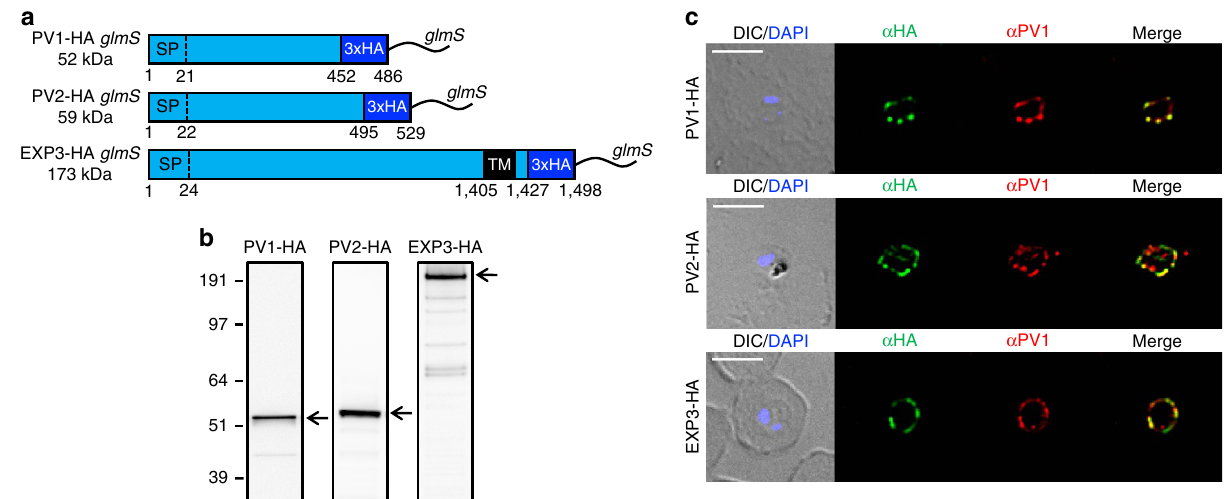
Figure 4 | Generating HA-tagged knockdown lines of novel PV proteins. ( a ) Schematic of endogenous PV1, PV2 and EXP3 proteins tagged with HA and glmS . Sizes of fusion proteins are indicated. All proteins contain predicted signal peptides (SPs) and EXP3 contains a predicted transmembrane (TM) domain. Numbers refer to amino acids. ( b ) Western blots were probed with anti-HA antisera to confirm PV1-HA, PV2-HA and EXP3-HA fusion protein expression in transfectants. Expected full-length fusion proteins are marked by arrows. Molecular masses are shown in kDa. ( c ) Immunofluorescence analysis of PV1-HA-, PV2-HA- and EXP3-HA-infected RBCs labelled with antisera recognizing HA (green) and PV1 (red). DIC and DAPI (blue) are shown on the left. Scale bars, 5 m present in the PV1-HA, PV2-HA and EXP3-HA glmS transfec-